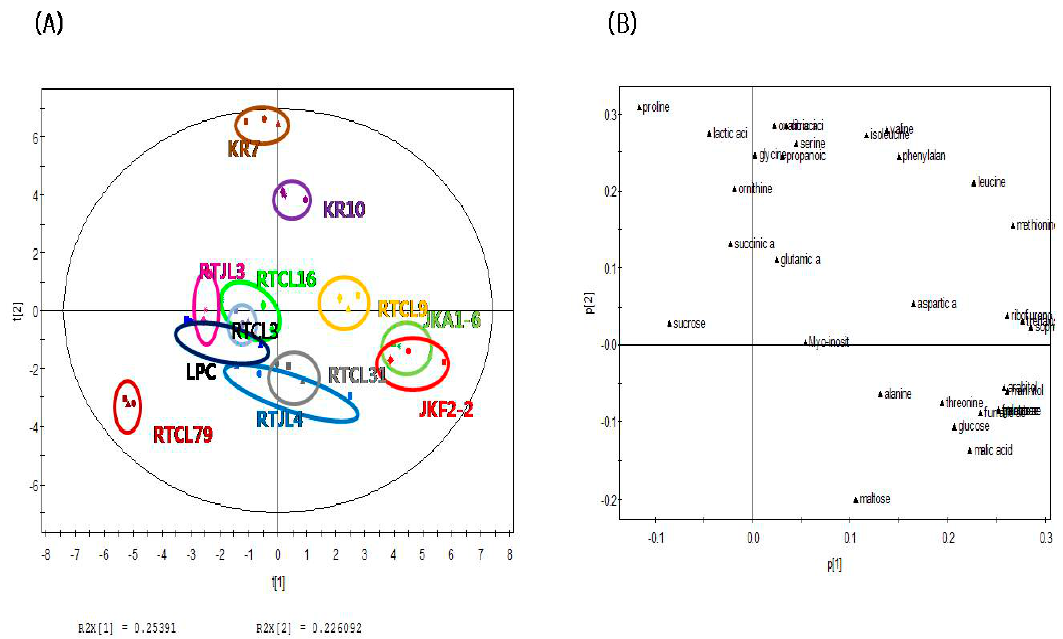
Figure 2. PCA plots of the nonvolatile volatile compounds identified in fermented rice according to strains of LABs: ( A ) score plot, ( B ) loading plot.